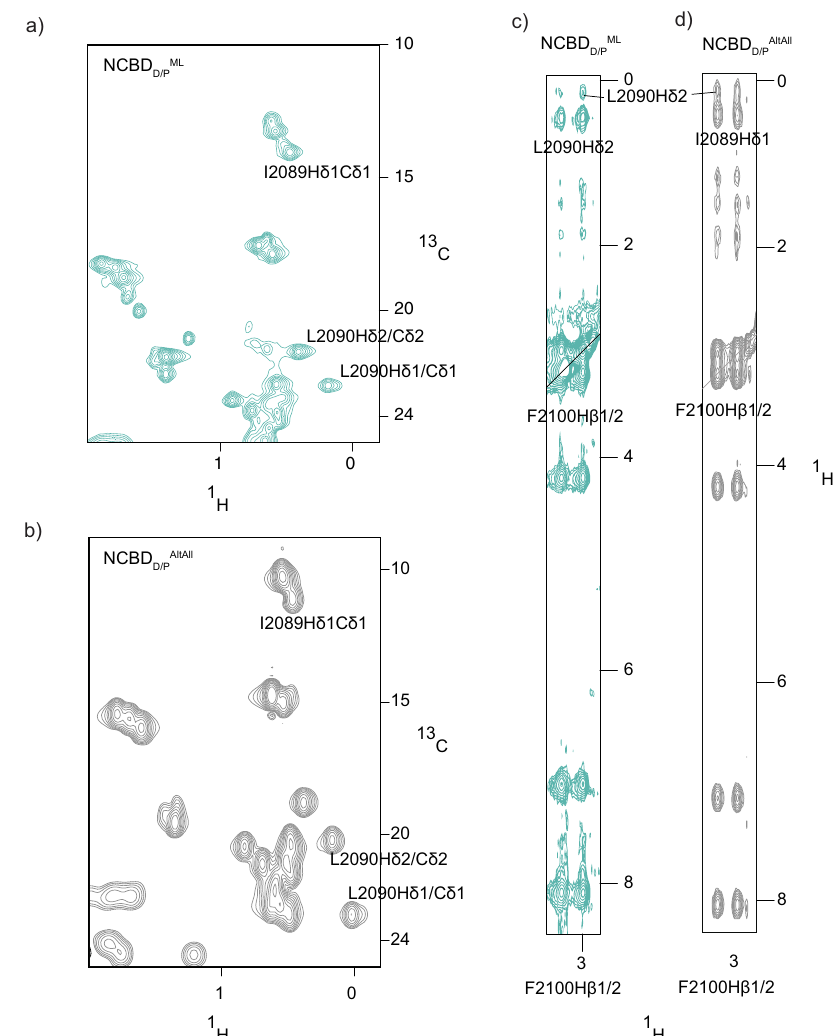
Fig. 3 Phe2100 makes NOEs to Ile2089 and Leu2090 in NCBD D/P ML and NCBD D/P AltAll . a 1 H- 13 C HSQC spectra at pH 2.4 of the methyl region of NCBD D/P ML , showing the H δ 1-C δ 1 shifts of L2090 and I2089. b 1 H- 13 C HSQC spectra at pH 6.8 of the methyl region of NCBD D/P AltAll , showing the H δ 1-C δ 1 shifts of L2090 and I2089. c Strip from a 1 H- 1 H 13 C-resolved NOESY showing NOEs from the H β 1/2 atoms of Phe2100 and the associated NOEs to Leu2090H δ 1 for NCBD D/P ML . d Strip from a 1 H- 1 H 13 C-resolved NOESY showing NOEs from the H β 1/2 atoms of Phe2100 and the associated NOEs to Leu2090H δ 1 and Ile2089H δ 1 for NCBD D/P AltAll . These signature NOEs imply that both proteins form a hydrophobic core similar to that of NCBD Human